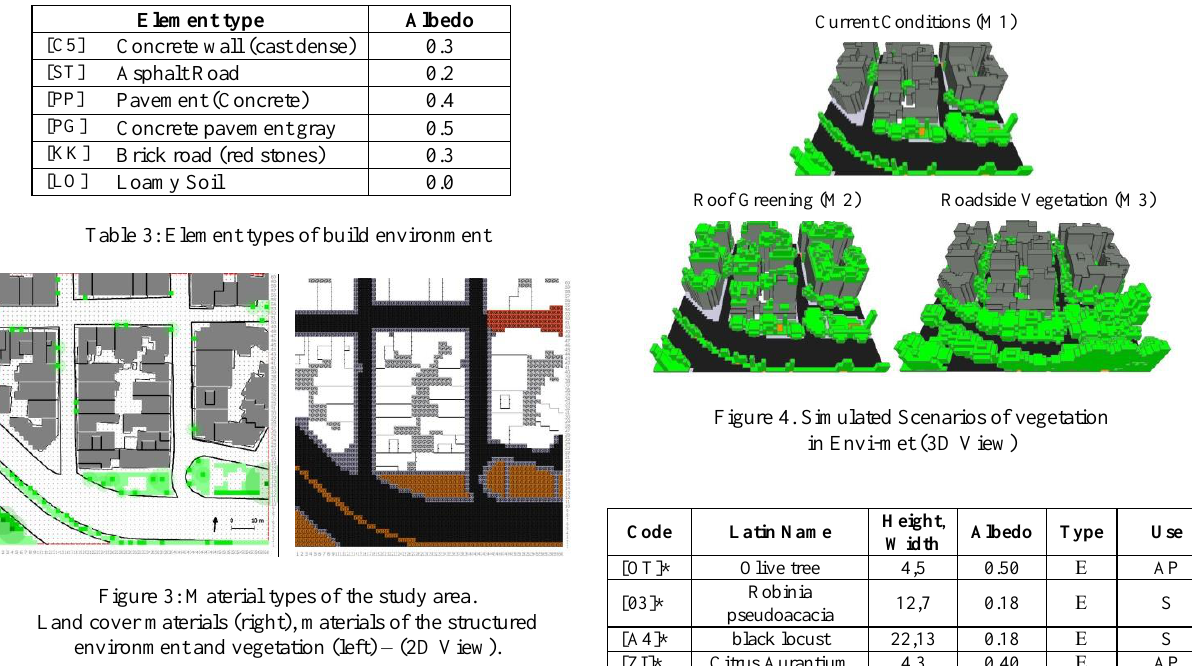
Table 2. Input Data of the study area in ENVI-met